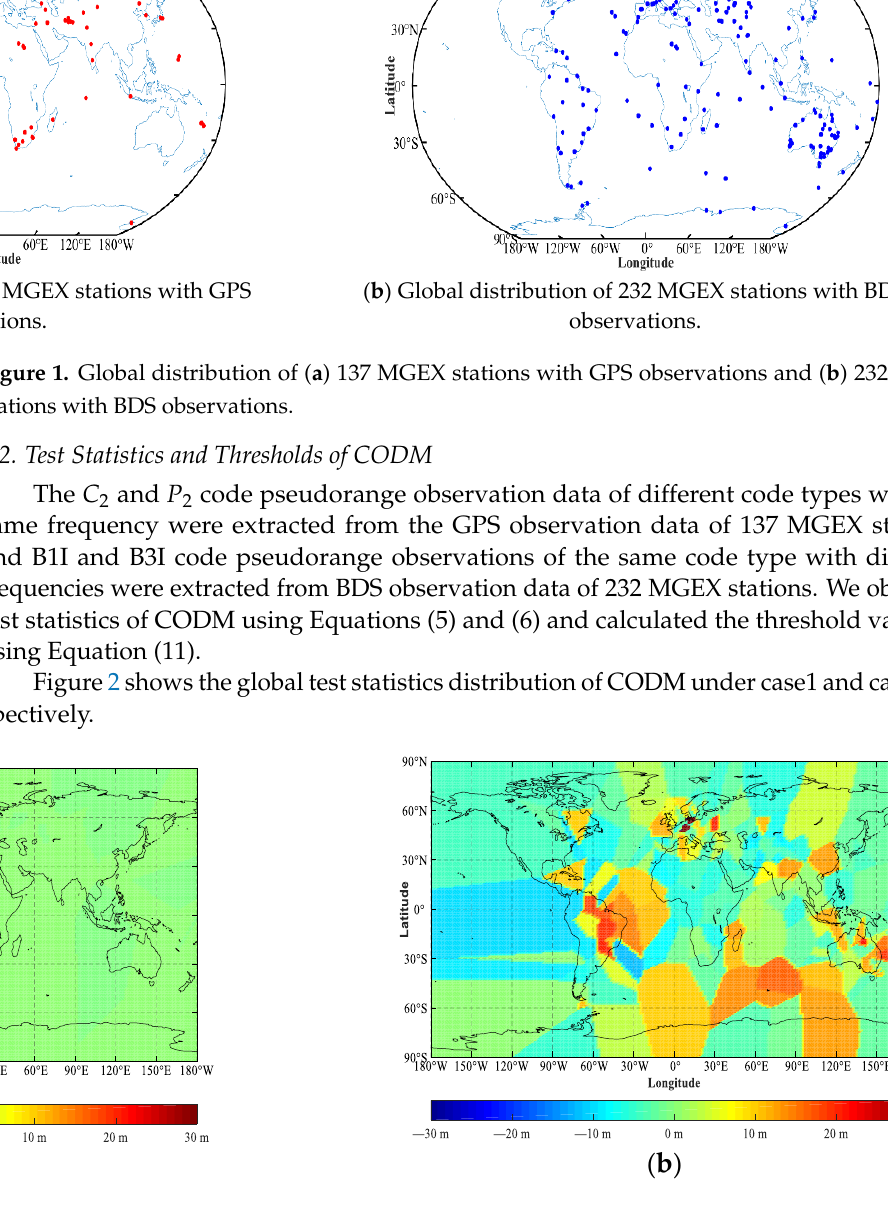
Figure 1. Global distribution of (a) 137 MGEX stations with GPS observations and (b) 232 MGEX stations with BDS observations.